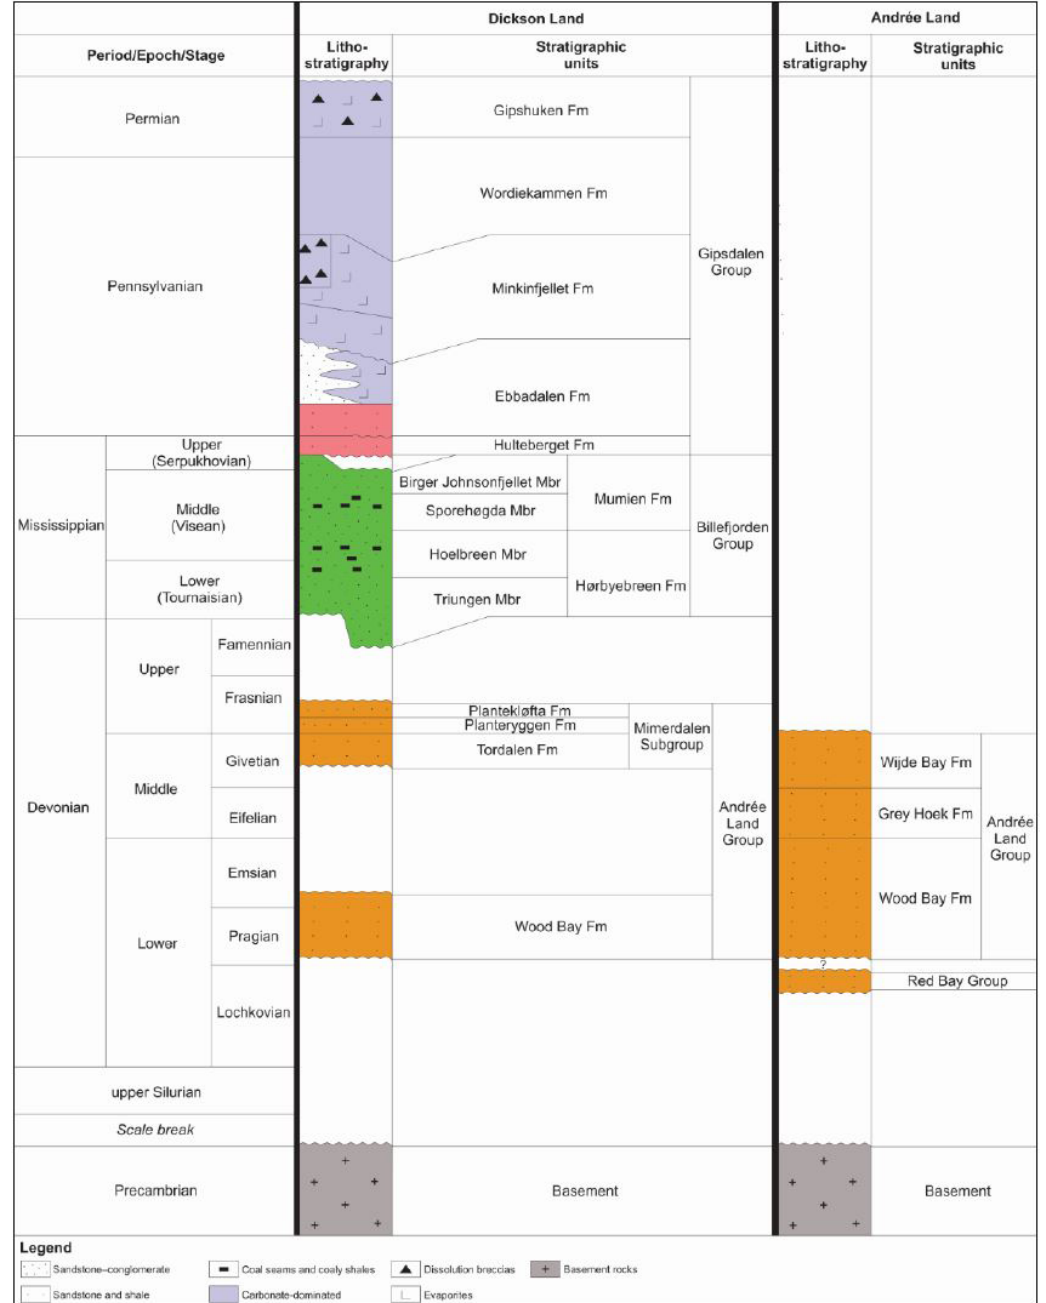
Figure 2. Stratigraphic chart for central (Dickson Land) and northern (Andrée Land)